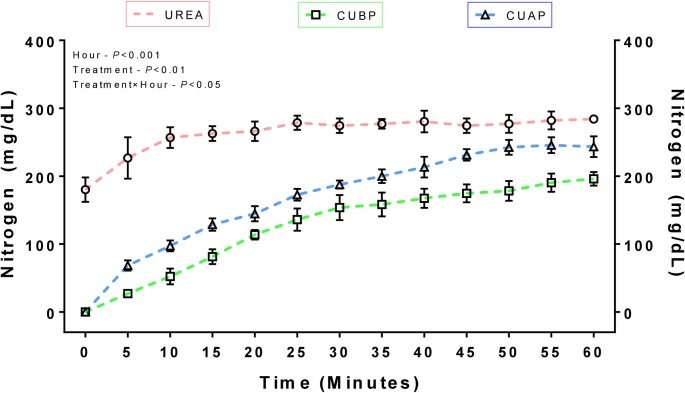
Nitrogen release from coated SRU products in vitro in distilled water compared to uncoated urea.Shown as means and standard errors of triplicate incubations (CUBP–Coated urea before processing, CUAP–Coated urea after processing).